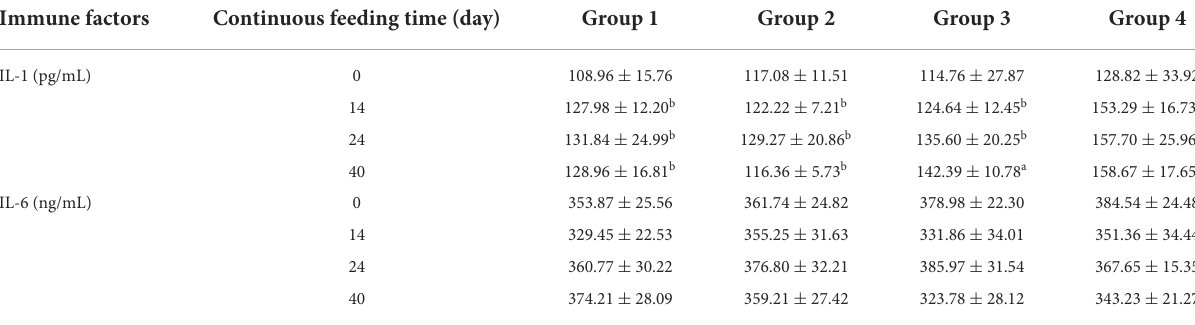
TABLE 7 Comparison of serum interleukins levels (mean ± SD) among four treatment groups ( n = 5 in each group). Immune factors Continuous feeding time (day)